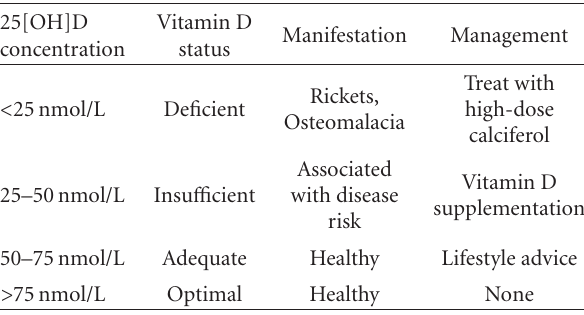
Table 1: Serum 25-hydroxyvitamin D (25[OH]D) concentrations, health, and disease (modified from